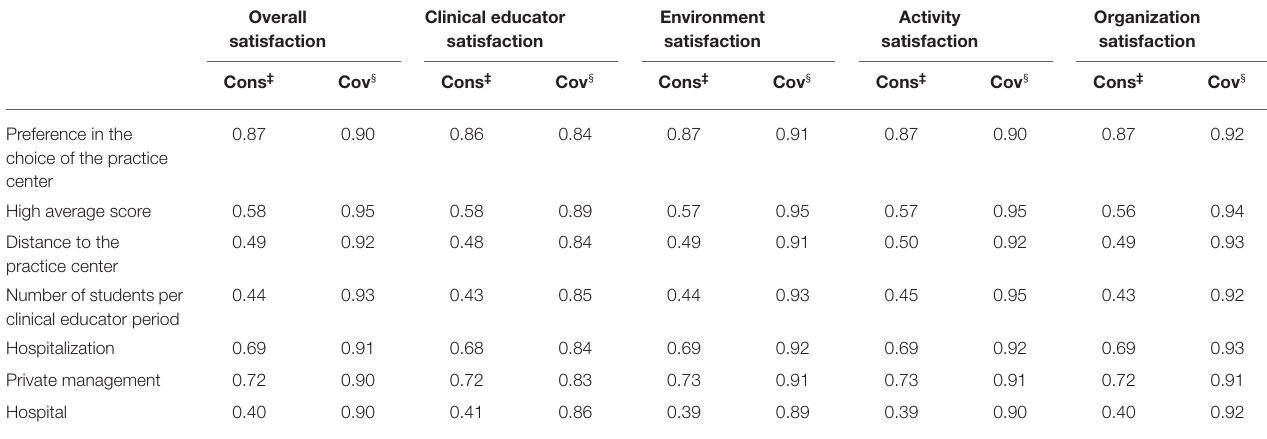
TABLE 4 | Necessary condition analysis for